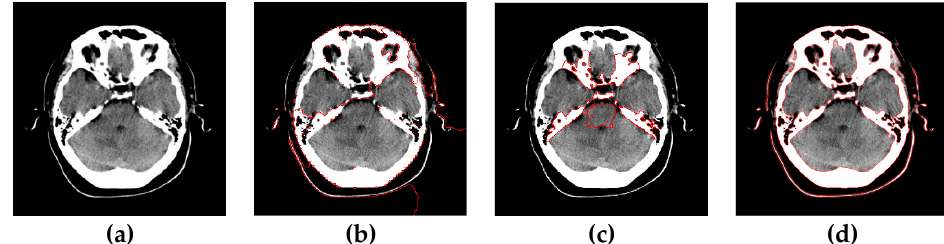
Figure 8. Comparisons of the three models in segmenting an image with a cerebral infarction: ( a ) The original image; ( b ) The segmentation results of the DRLSE model; ( c ) The segmentation results of the LSACM model; ( d ) The segmentation results of the IRLS-IS model.